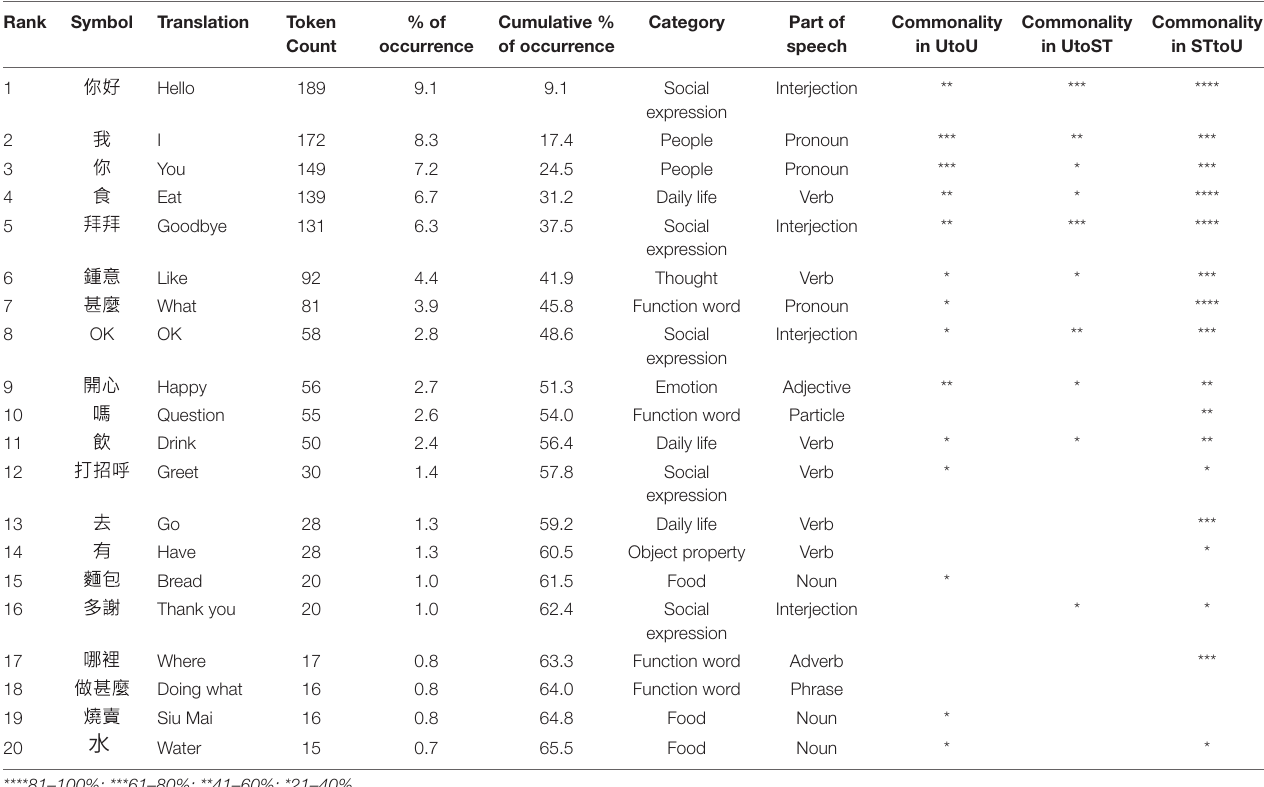
TABLE 1 | Features of the most frequently used symbols in the dataset. Rank Symbol Translation